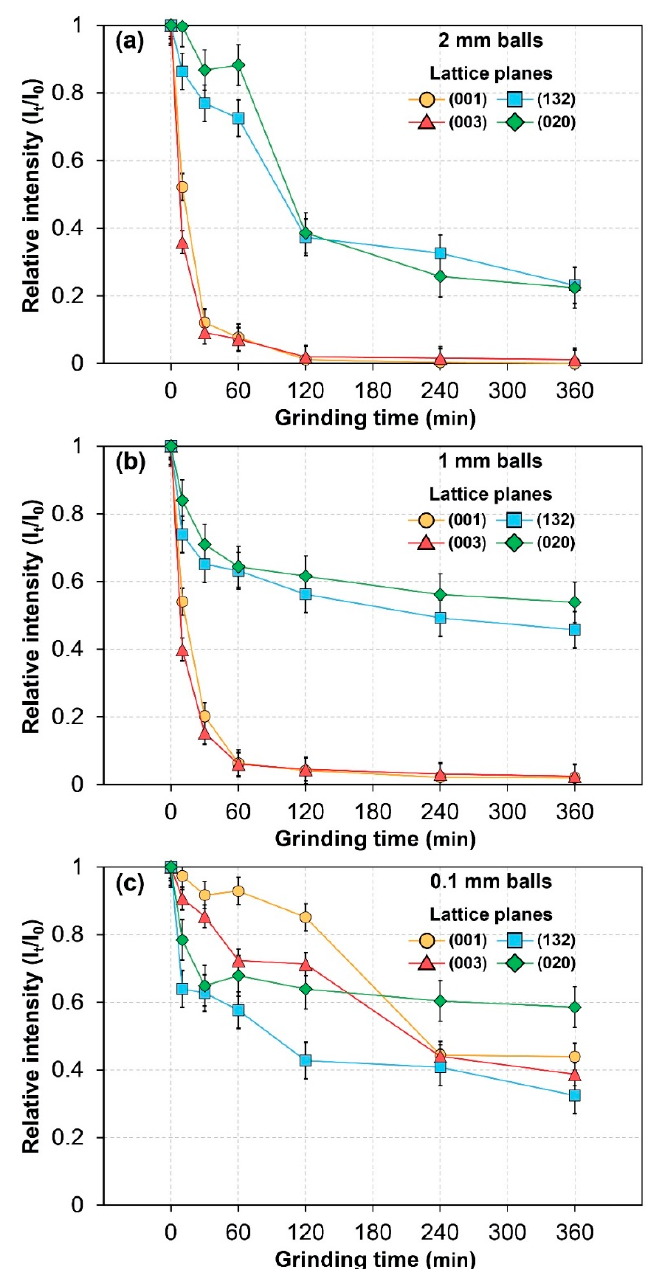
Figure 4. E ff ects of grinding time and ball size on the relative XRD intensities of lattice planes. The ball size for high-energy ball milling is ( a ) 2 mm, ( b ) 1 mm, and ( c ) 0.1 mm. The relative peak intensities are normalized with the XRD peak of as-received talc.